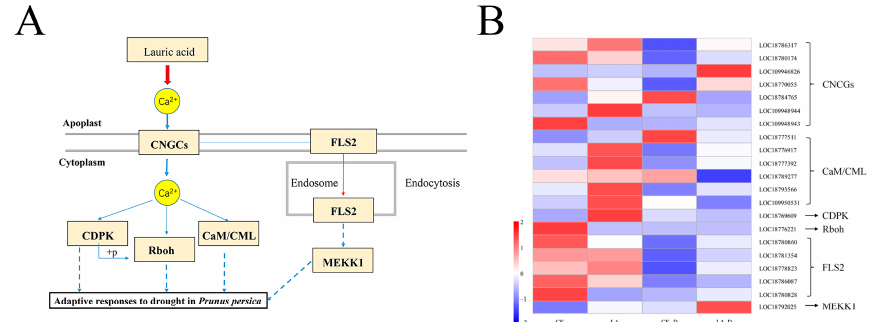
Figure 10. The Ca 2+ signaling pathway induced by lauric acid in P. persica during drought stress ( A ) and a heat map of expression levels of CNGC, CAM/CML, CDPK, Rboh, FLS2, and MEKK1 ( B ). The expression levels were assessed by log2-transformed FPKM values.